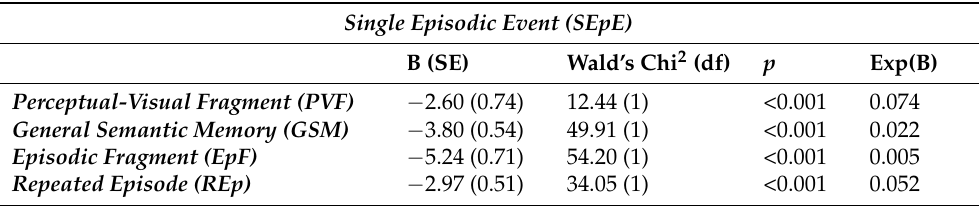
Table 1. Predictive effect of the perceptual-visual fragment, general semantic memory, episodic fragment, and repeated episode on Single Episodic Event memory (n = 277).